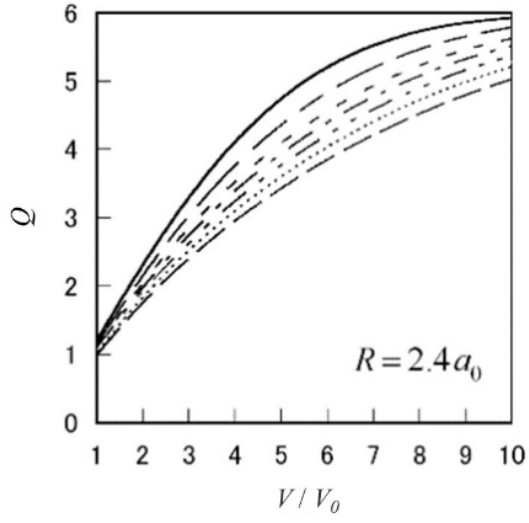
Figure 11. Average charge of a C n + ( n = 2 − 20 ) ion with equal separation of R = 2.4 a 0 in ring structure. Long dashed line ( n = 2), short dashed line ( n = 3), dot dashed line ( n = 4), dot-dot-dashed line ( n = 6), dotted line ( n = 10), dashed line ( n = 20)